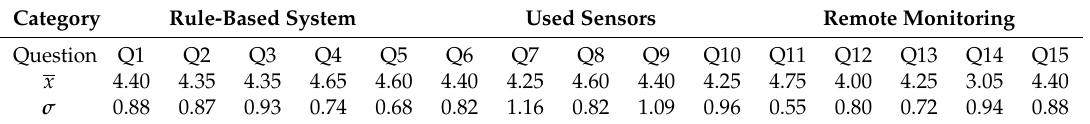
Table 6. Mean and standard deviations result for experimental questions.